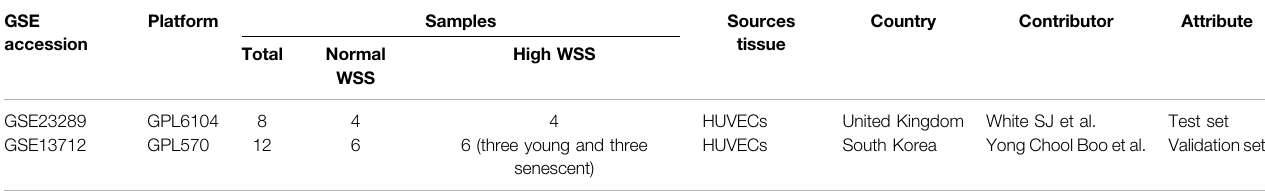
TABLE 1 | Information for selected GEO microarray data